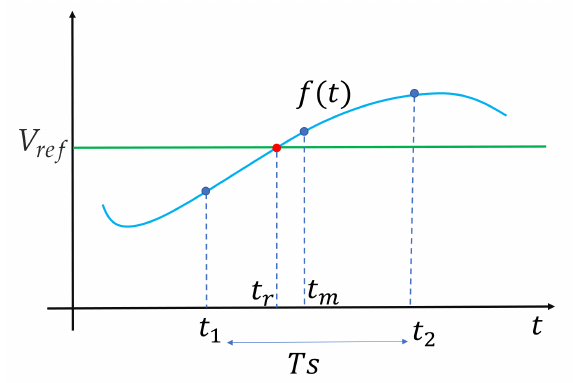
Figure A1. Graphical description for bisection numerical method.